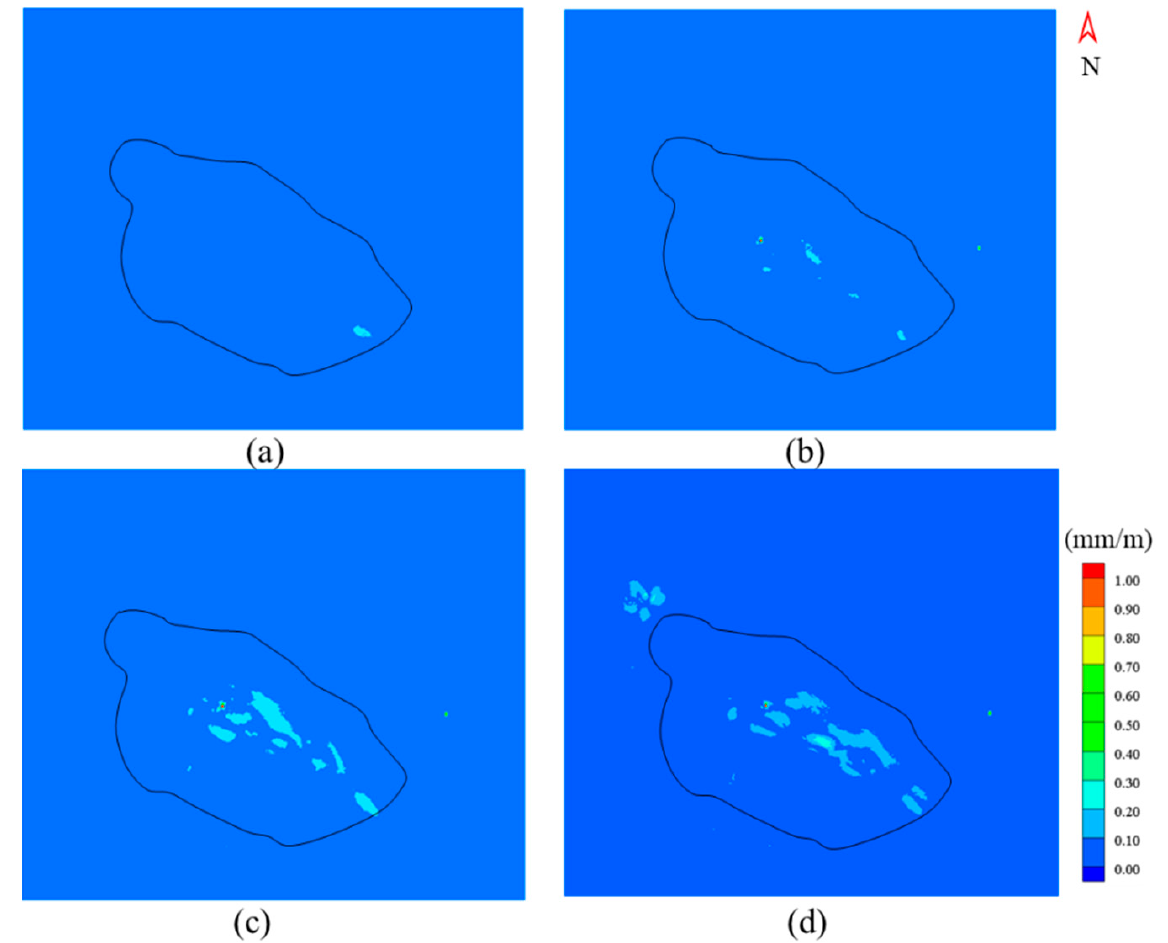
Figure 18. Surface horizontal strain ( a ) moment 1; ( b ) moment 2; ( c ) moment 3; ( d ) moment 4.